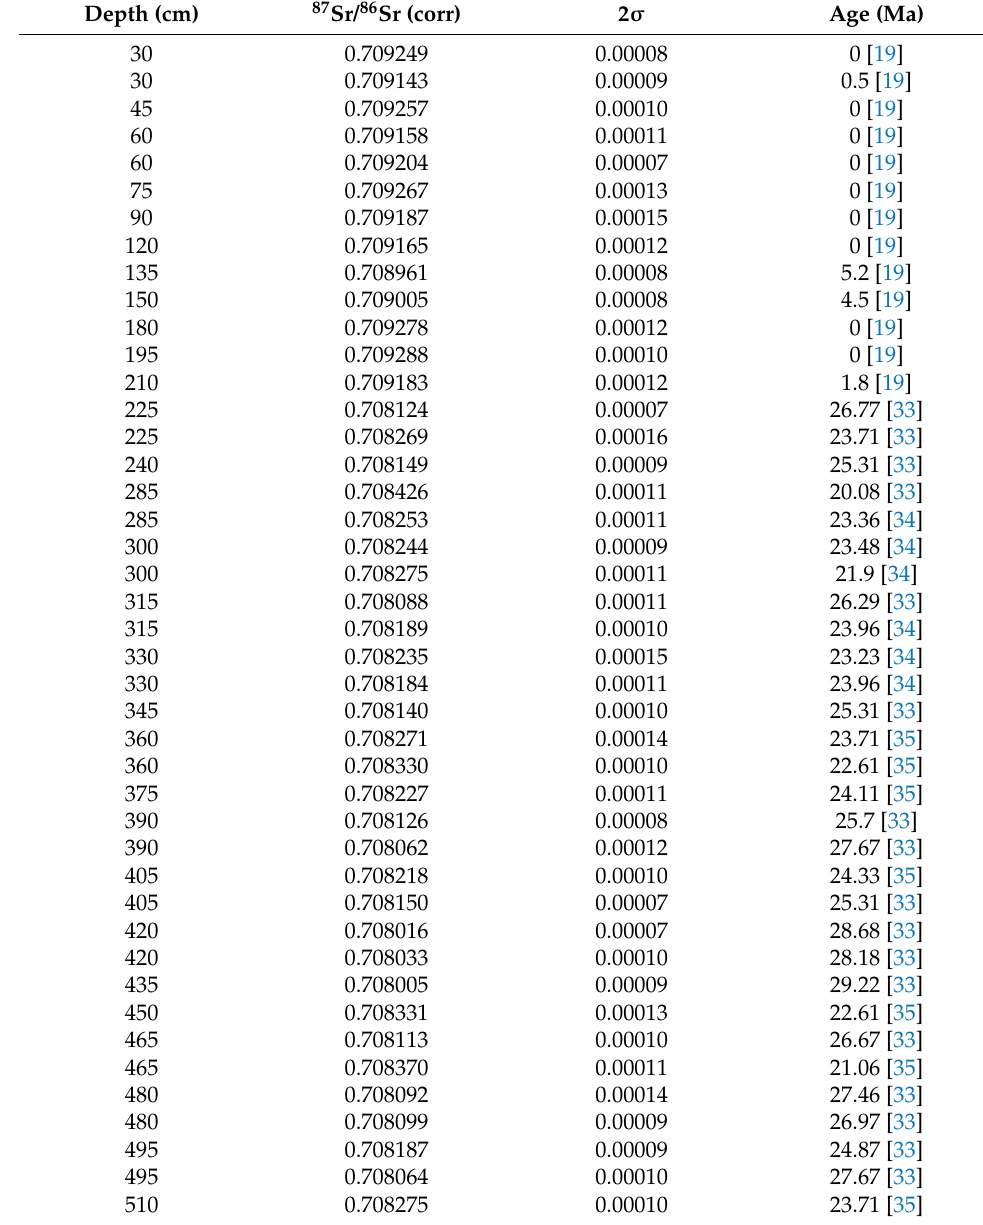
Table 2. Strontium isotopic data for P10 fish teeth